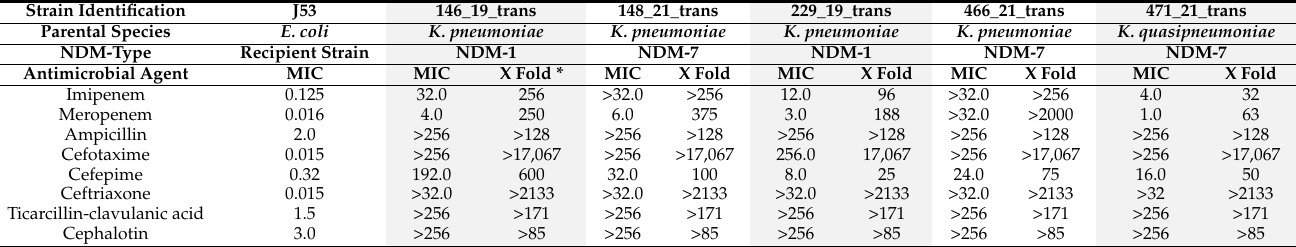
Table 2. Antimicrobial susceptibility testing (MIC values, in µ g/mL) of NDM-producing transconju- gant strains. For comparison, the results for the J53 E. coli recipient strain are also presented. Strain